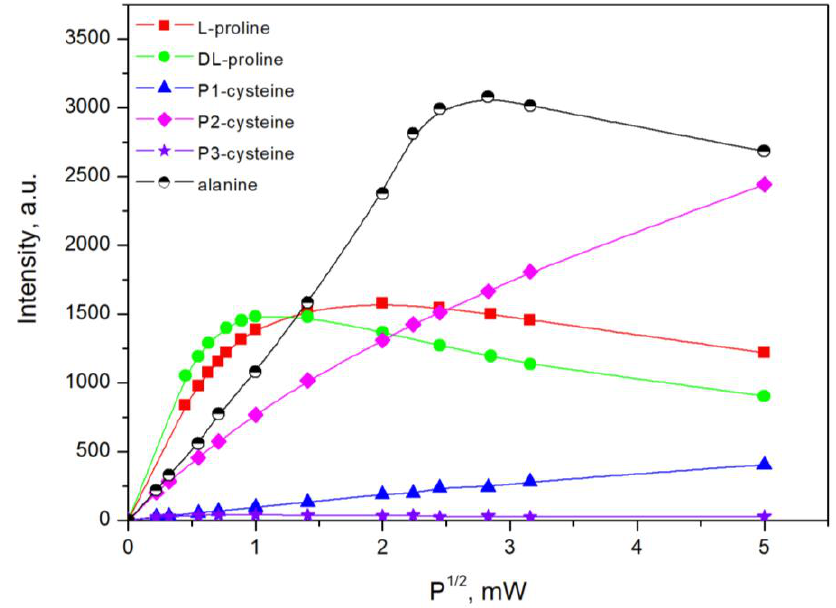
Figure 4. The dependence of the EPR intensity on the square root of the microwave power.